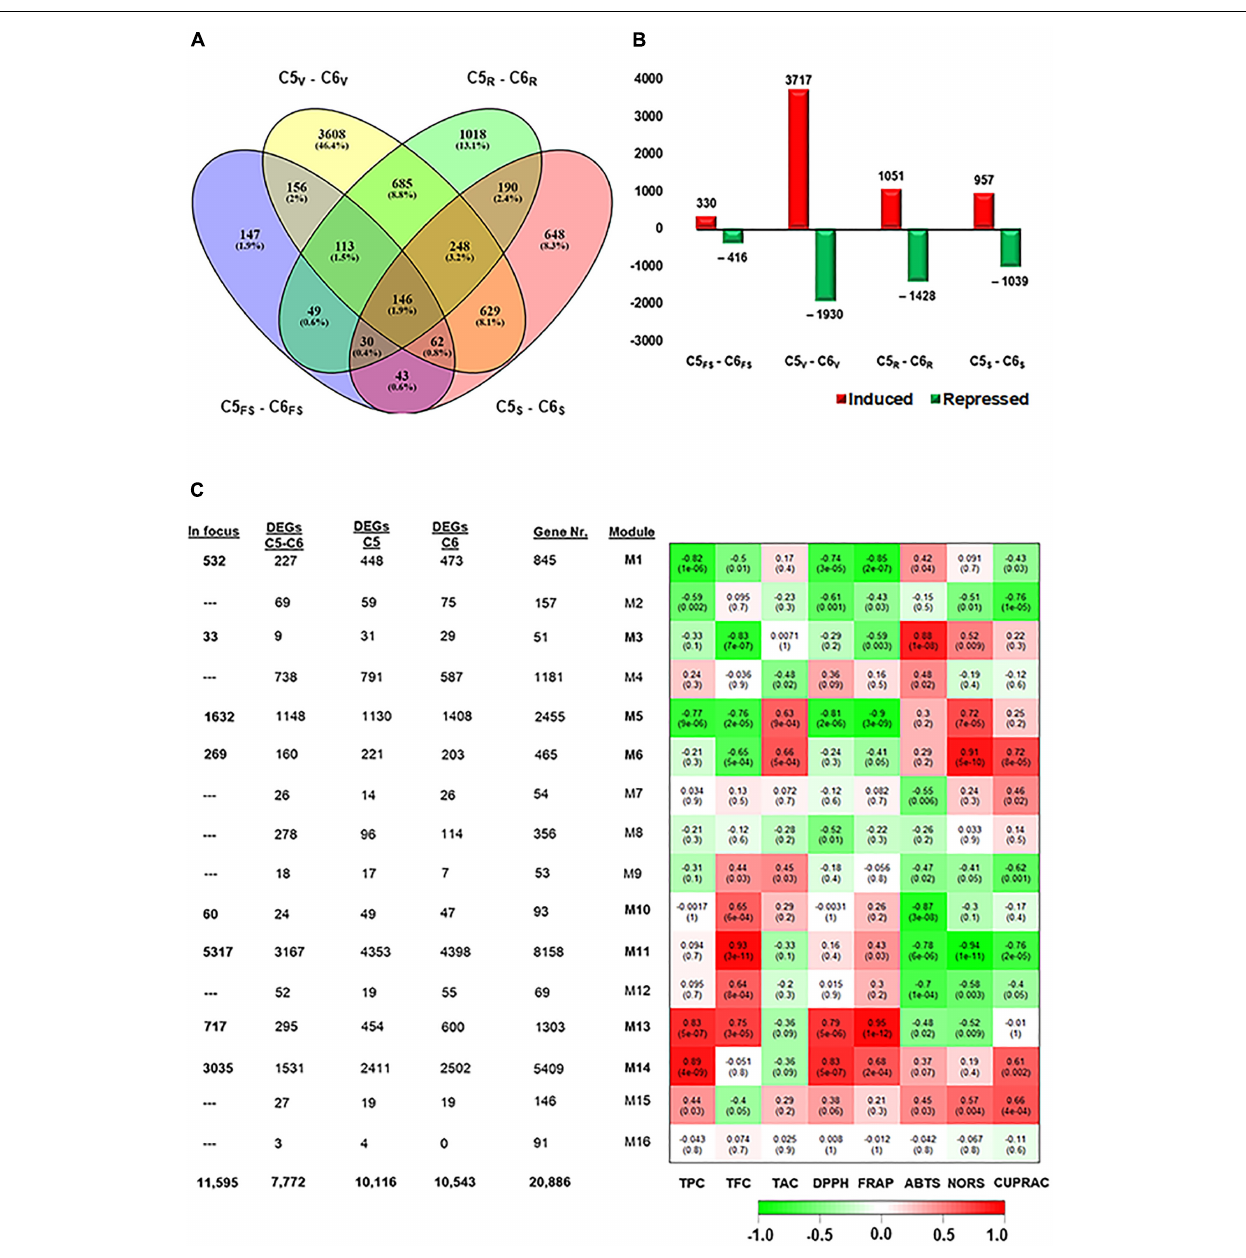
FIGURE 2 | Differentially expressed genes among C5 stages and their corresponding stages in C6. (A,B) Venn diagrams and bar plots of DEGs resulted from comparing equivalent stages in C5 and C6 genotypes, using DESeq2 or EdgeR pipelines. As a result, 7772 non-redundant DEGs were identified with log2fold change > 1.5 or < –1.5. (C) Module-trait associations between RNA-seq data and evaluated biochemical-related traits, including TPC, TFC, total anthocyanin content (TAC), and different types of antioxidant assays (DPPH, FRAP, ABTS, NORS, and CUPRAC) from the C5 and C6 genotypes at different berry developmental stages. The color of the cell indicates the correlation coefficient between a given module and biochemical-related traits at the row-column intersection. Each row corresponds to a module (M1–M16). The left panel shows the assigned number of genes to each module, whether the number of total input genes or DEGs from C5 stages , C6 stages , and C5 stage – C6 stages comparisons. In addition, modules of interest were shown in bold line and selected for further analysis (indicated as in focus). Green and red are the color key that represents r 2 values from –1 to +1. FS, fruit-set; V, véraison; R, ripe skin/flesh; S, ripe